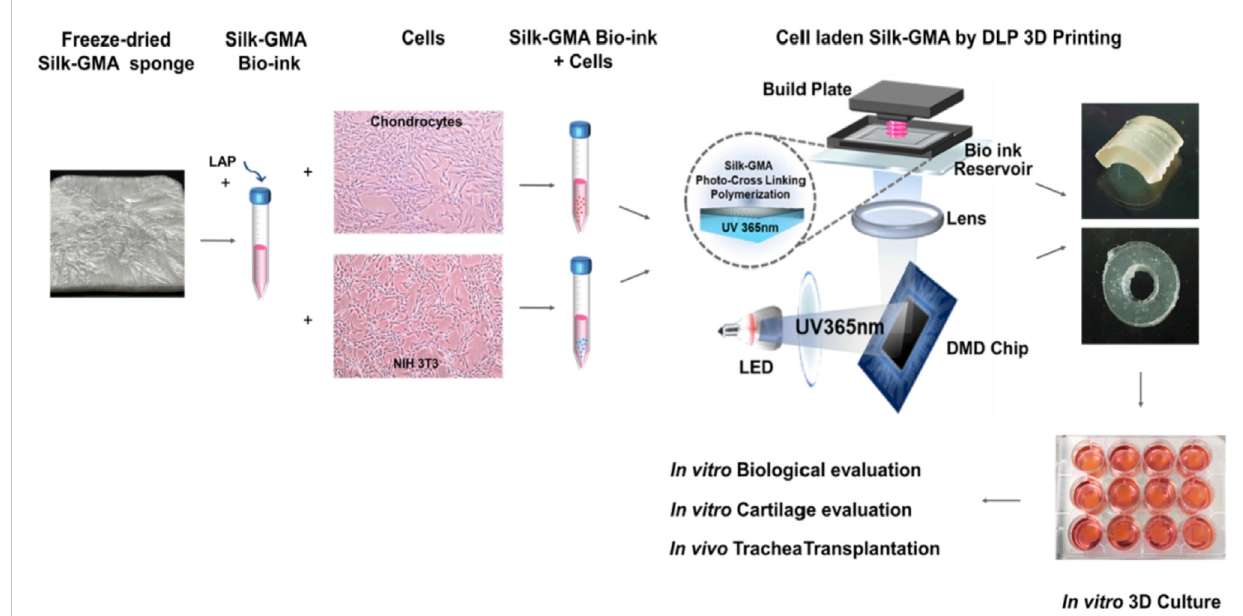
FIGURE 9 Chondrocyte-ladenedsilk-GMAbio-ink for DLP3Dprinting technologyhas great potential incartilageregeneration. Adapted with permission